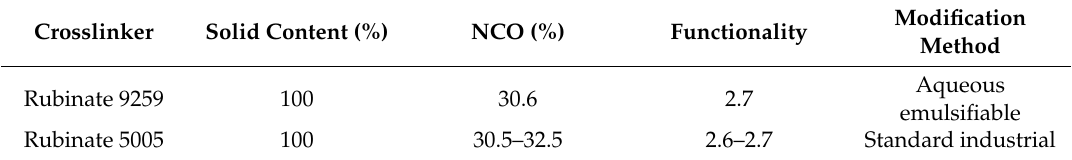
Table 1. Characteristics of polymer isocyanate (emulsion polymer isocyanate (EPI) crosslinkers)